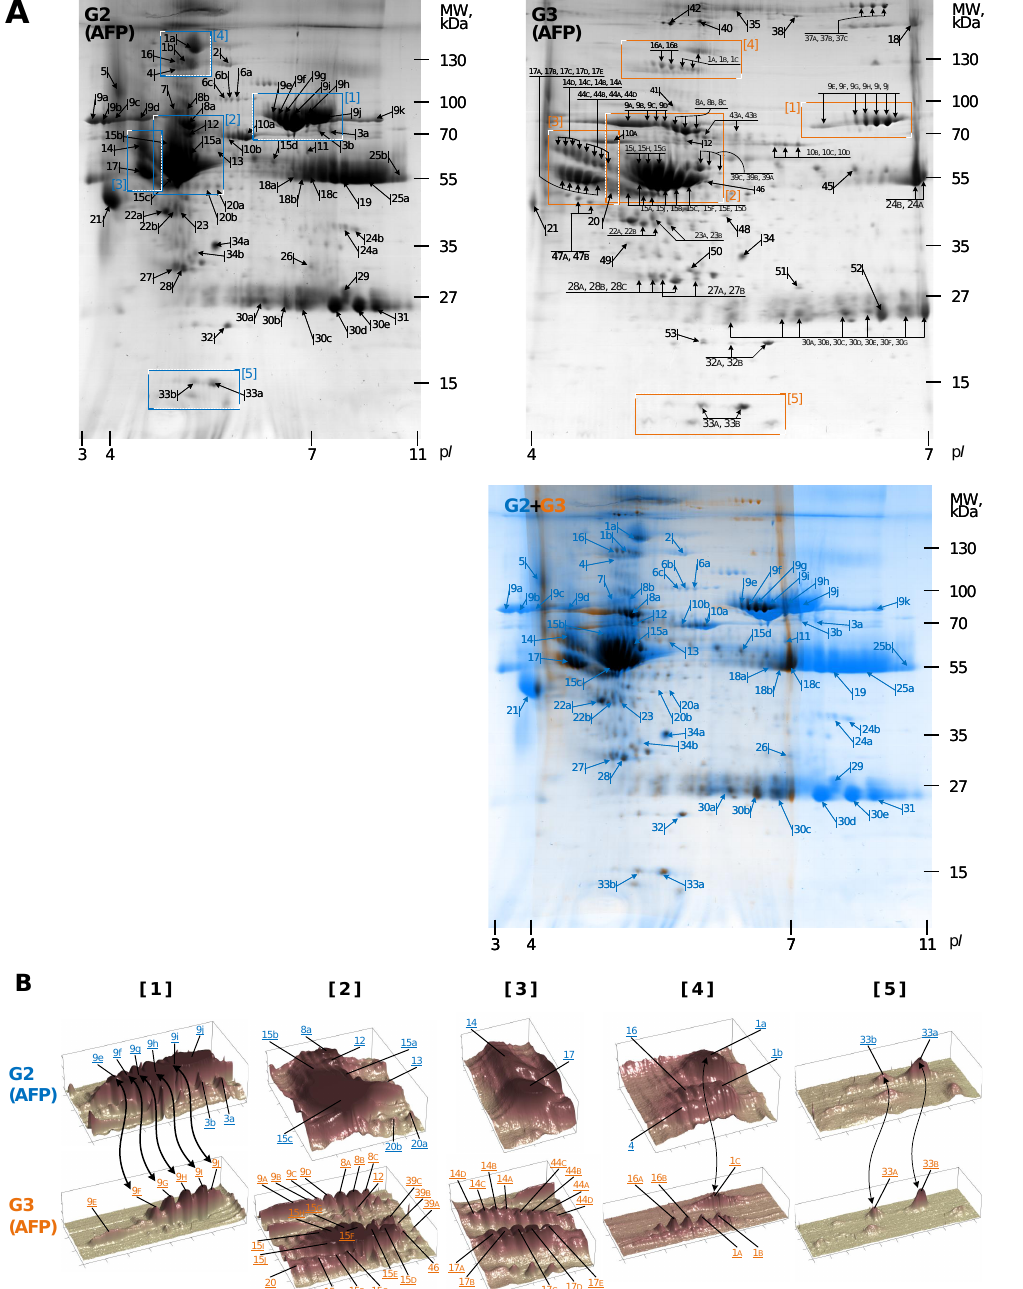
Figure 2. Comparative analysis of 2DE protein maps corresponding amniotic fluid of polyhydram- nios pregnancy fractionated in different pI range. ( A ) proteins corresponding amniotic fluid of polyhydramnios pregnancy (AFP), fractionated in different pI range: pI 3–11 (G2, blue in G2 + G3) and pI 4–7 (G3, orange in G2 + G3) range and Excel Gel SDS, gradient 8–18%. Arrows and numbers in the 2DE maps indicate the positions of proteins supplied to MALDI-TOF MS/MS and identified. Spot labels for the proteins fractionated in the range pI 3–11 are the same as in Table 2. Spot labels for the proteins fractionated in the range pI 4–7 are the same as in Table 2. ( B ) Computational analysis of several protein groups is performed to evaluate their distribution in different pI value ranges. It shows that the same protein level with different pI changes because of modification level. In Table 2, the proteins’ spot distribution corresponding to the different modification level is presented (column— Share, %). Representative images from one of three experiments showing similar results are